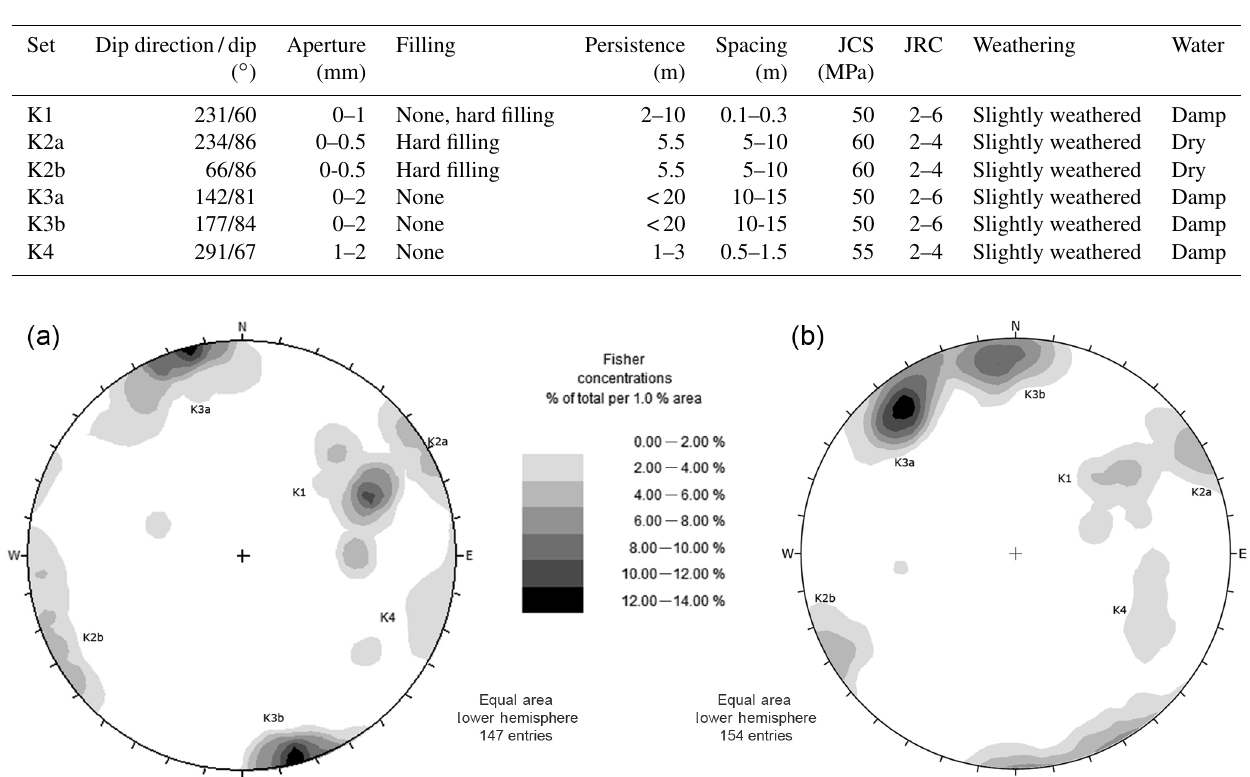
Table 3. Characteristics of the discontinuity sets measured based on traditional manual engineering geological survey in the study area. The joint roughness coefficient (JRC) and joint compressive strength (JCS) are also indicated.